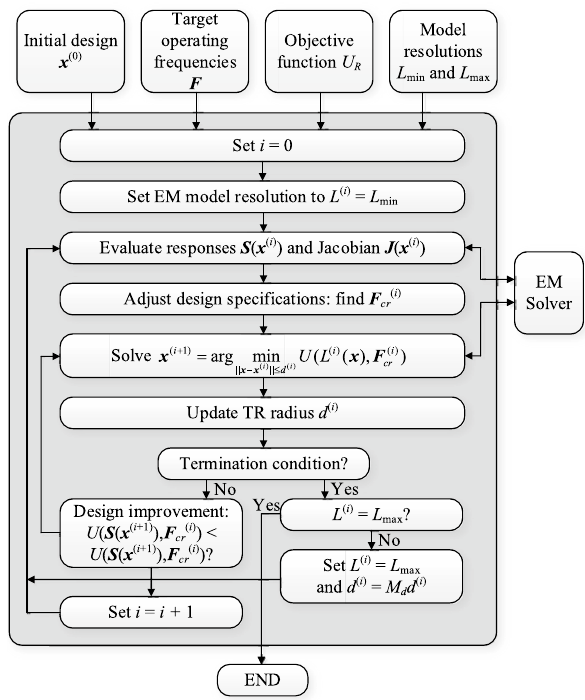
Figure 5. Flow diagram of the introduced optimization algorithm with design requirement adjustment and variable-fidelity EM models.